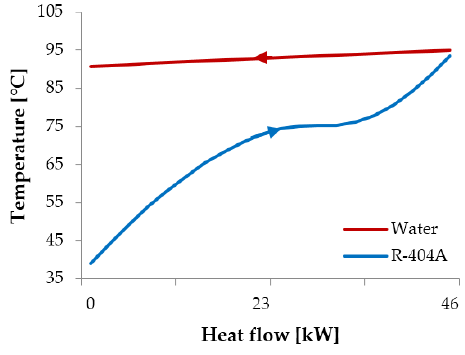
Figure 8. Pinch point temperature difference at the outlet of the heat exchanger at 95 °C inlet temperature.